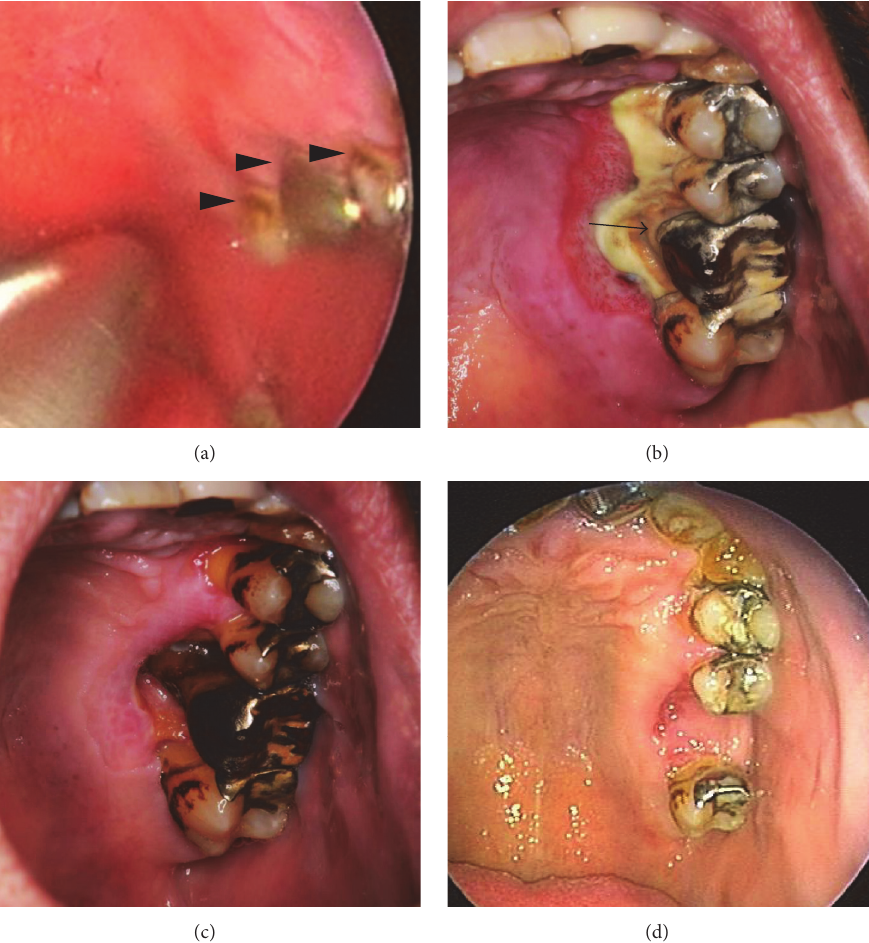
Figure 1: Temporal changes in the gingiva around the left upper teeth. (a) At the initial visit, plaque and calculus were observed on the tooth surface (arrowhead), and pockets had developed especially around his maxillary left first molar, which had been capped in silver. (b) Nine days after embolization, necrotizing ulcer formation was observed on the gingiva on the palatal side of the maxillary left premolar and molar teeth. The alveolar bone was exposed due to loss of gingiva (arrow). (c) At 2 weeks after treatment, resorption of the alveolar bone had occurred, and the palatal side of the first molar was fully exposed. Granulation tissue proliferated around the edge of the defect. (d) At 2 months after treatment, the wound was replaced by granulation tissue and epithelialized almost completely, with the exception of the deep socket on the palatal